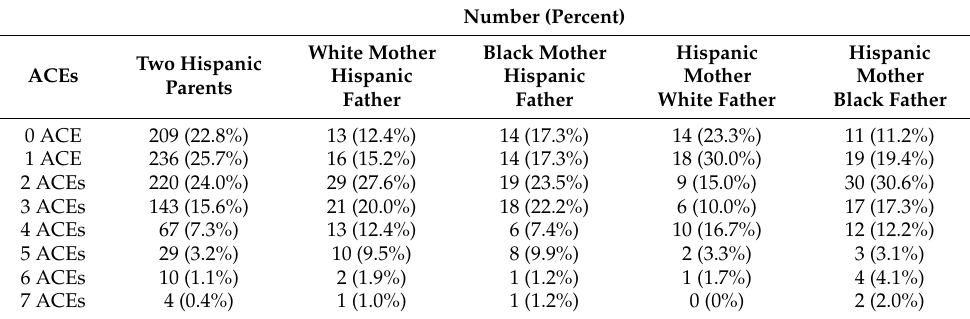
Table 2. ACEs breakdown among different family racial composition